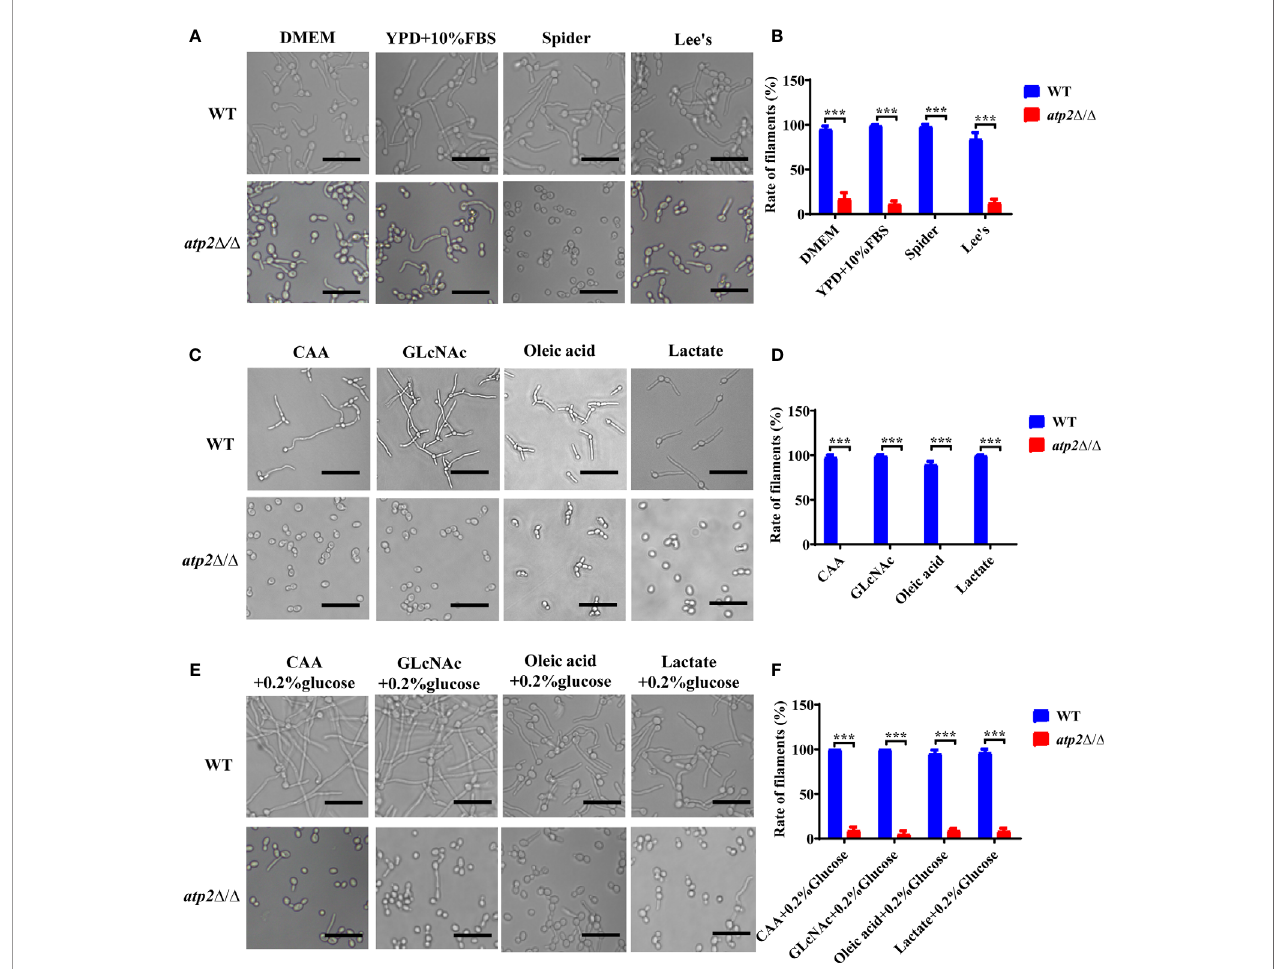
FIGURE 7 | Hyphae formation of C albicans in various environments. (A, B) Representative images and hyphal cell percentages of WT and atp2 D / D cultured in DMEM, YPD+10% FBS, Spider, and Lee ’ s medium at 37°C for 3 h. (C, D) Representative images and hyphal cell percentages of WT and atp2 D / D cultured in CAA, GLcNAc, oleic acid, and lactate medium at 37°C for 3 h. (E, F) Representative images and hyphal cell percentages of WT and atp2 D / D cultured in CAA, GLcNAc, oleic acid, and lactate medium supplemented with 0.2% glucose at 37°C for 3 h. In (B, D, F) the percentage of hyphal cells in each medium was calculated from at least 100 cells. The assays were performed in triplicate. *** P <0.001; by Student ’ s t